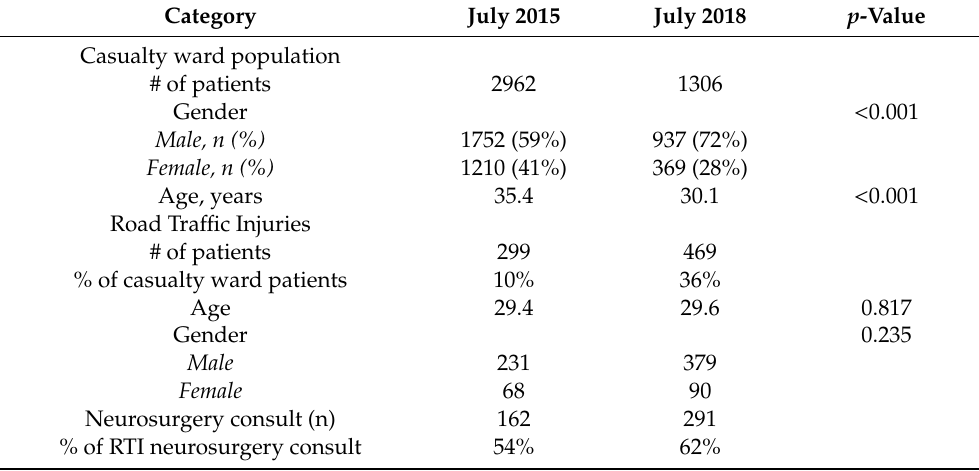
Table 3. RTIs presenting at the Mulago National Referral Hospital (MNRH) casualty ward in